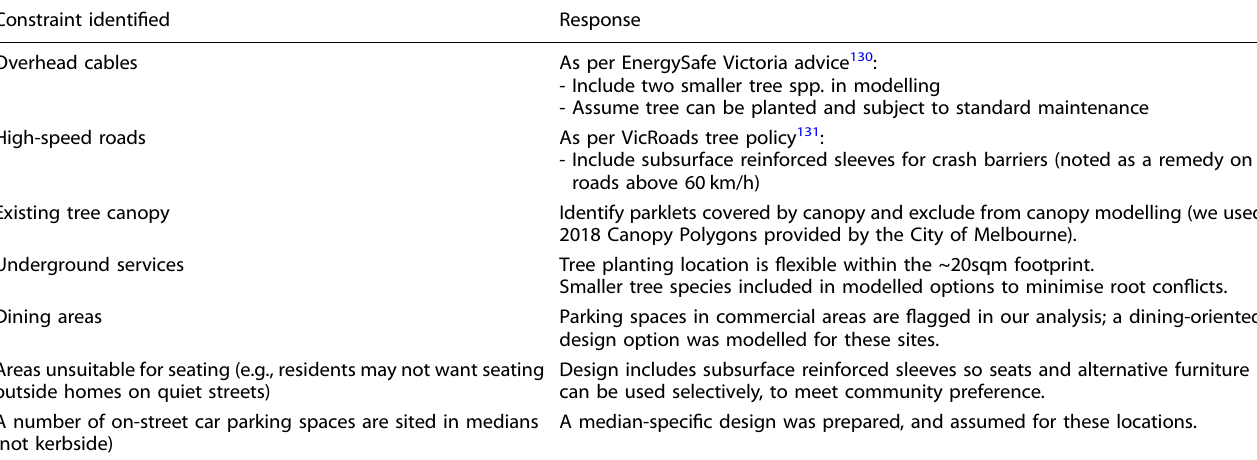
Table 3. Constraints guiding the design.